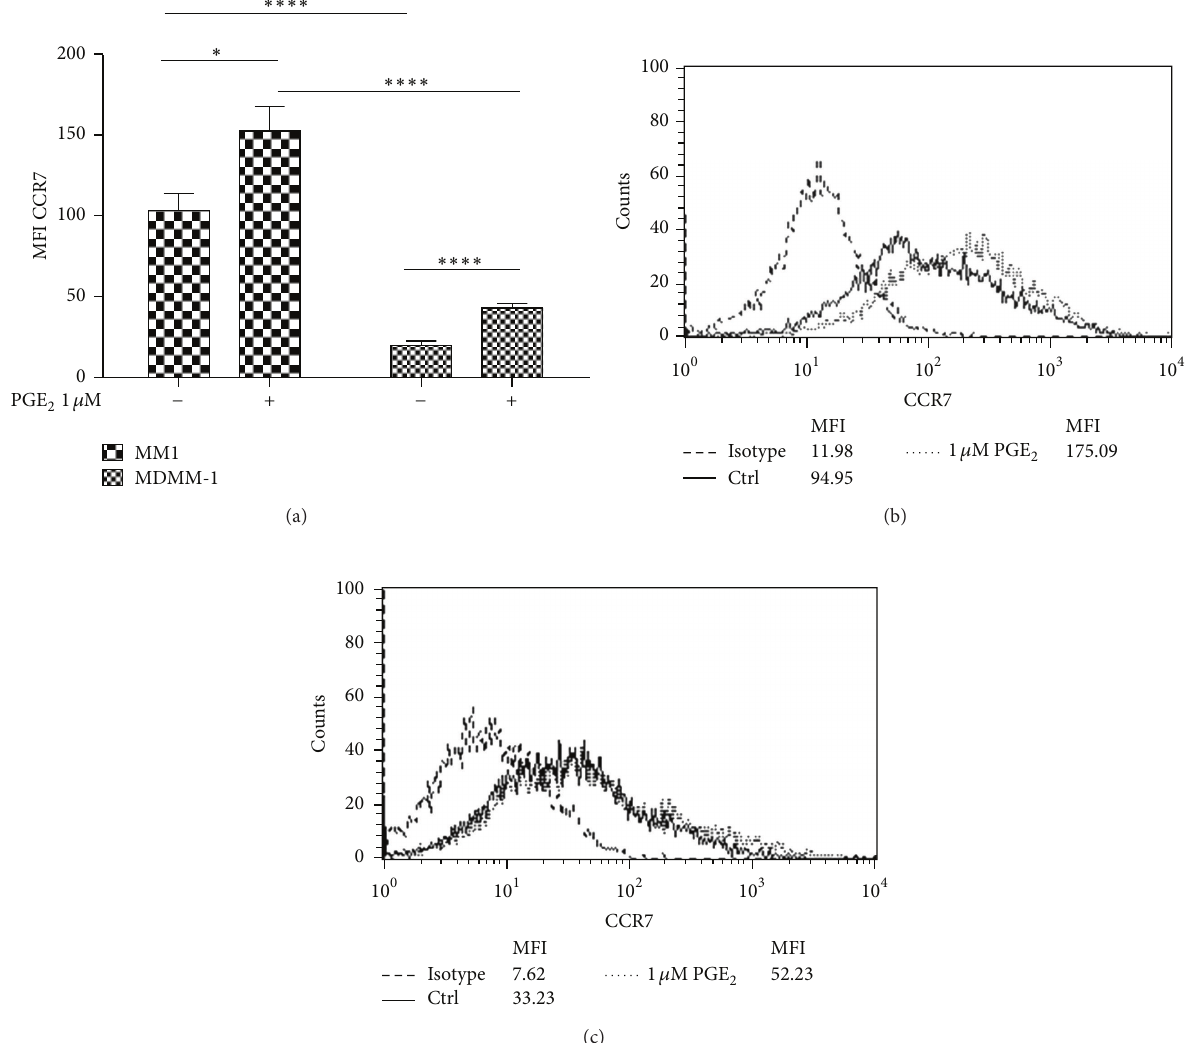
Figure 3: Differentiation of Mono Mac-1 cells into MDMM-1 cells induces the loss of CCR7 expression. Mono Mac-1 cells were differentiated in MDMM-1 cells as described. (a) CCR7 surface expression was evaluated by flow cytometry on Mono Mac-1 and MDMM-1 cells following treatment with 1 𝜇 M PGE 2 for 24 h. Data are the mean of four representative experiments, and representative histograms obtained for Mono Mac-1 (b) and (c) MDMM-1 cells are presented. ∗ 𝑃 < 0.5 , ∗∗ 𝑃 < 0.005 , ∗∗∗ 𝑃 < 0.001 , and ∗∗∗∗ 𝑃 < 0.0001